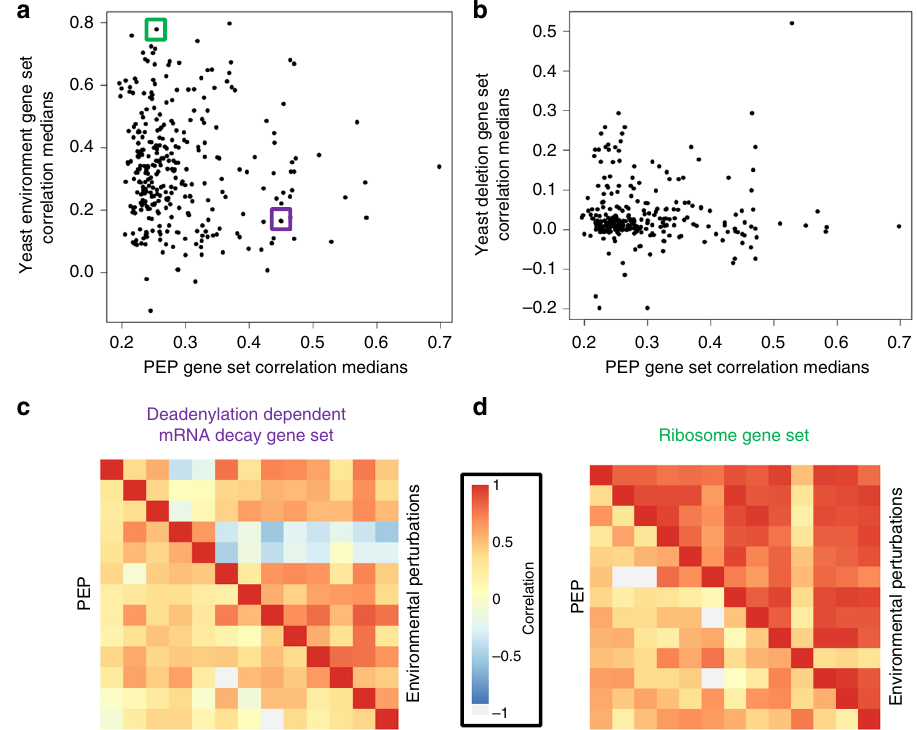
Fig. 3 Comparison of PEP with cross-environment and cross-genotype expression pro fi ling methods. a Scatterplot of the gene-set correlation medians for the gene sets found as signi fi cant using the PEP method introduced here vs. the correlation medians for the same gene sets in a data set of yeast expression across environments. The gene sets boxed in purple and green are highlighted in c and d , respectively. b Scatterplot of gene-set correlation medians as in a , but comparing PEP to yeast expression across deletion strains (i.e., across genotypes). c Comparison of gene-gene correlations for the deadenylation dependent mRNA decay gene set highlighted in a for the PEP method (lower triangle) and classical yeast coexpression correlations across environments (upper triangle). d Comparison of gene – gene correlations for the ribosome gene set highlighted in a as described in (Fig. 4a; Spearman ’ s ρ = − 0.52, p = 2.4 × 10 − 24 ), which is